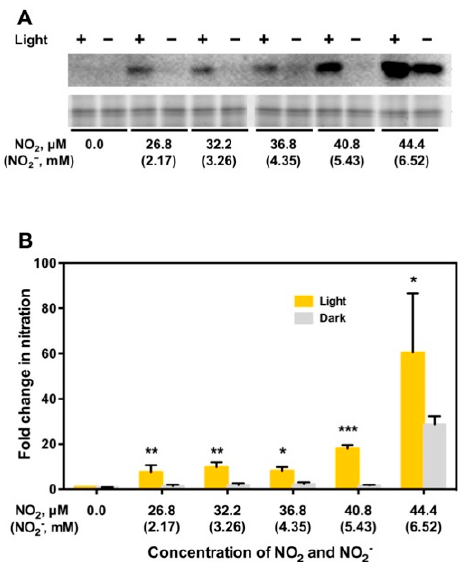
Figure 5. Demonstration that light is essential to induce nitration of PsbO1. ( A ) Arabidopsis thylakoid membranes were incubated in a bu ff er containing NO 2 and NO 2 − with or without illumination. Upper and lower panel show 3-NT-positive band and SYPRO-Ruby-stained band of PSBO1, respectively. ( B ) Fold-change in the PsbO1 band intensity (FCPSBO1) as a function of NO 2 and NO 2 − concentrations in a bu ff er solution bubbled with NO 2 gas. FCPSBO1 = (PsbO1 band intensity following incubation in a bu ff er bubbled with NO 2 gas) / (PsbO1 band intensity following incubation in bu ff er without NO 2 or NO 2 − ). Data represent means of 3 independent experiments ± SD. *, P < 0.05; ***, P < 0.001. Student’s t -test was done using GraphPad Prism 6.0 (GraphPad Software, La Jolla, CA, USA).